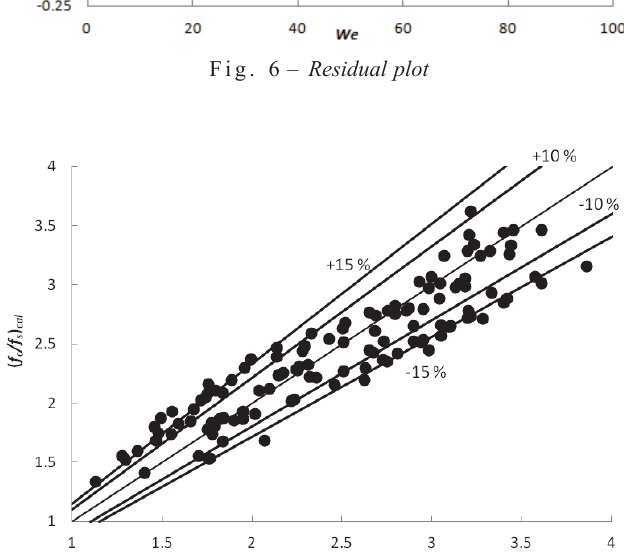
Fig. 7 – Parity between the observed friction factor ratio, ((f /f ) ) and the model predicted values, ((f c s exp Table 3 – Uncertainty analysis for the proposed model Average of (( f